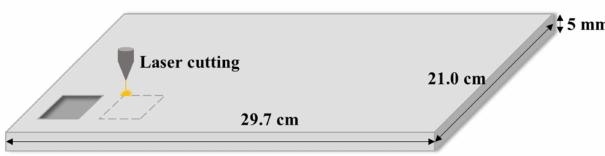
Figure 5. Schematic of the laser processing method to fabricate the mold.